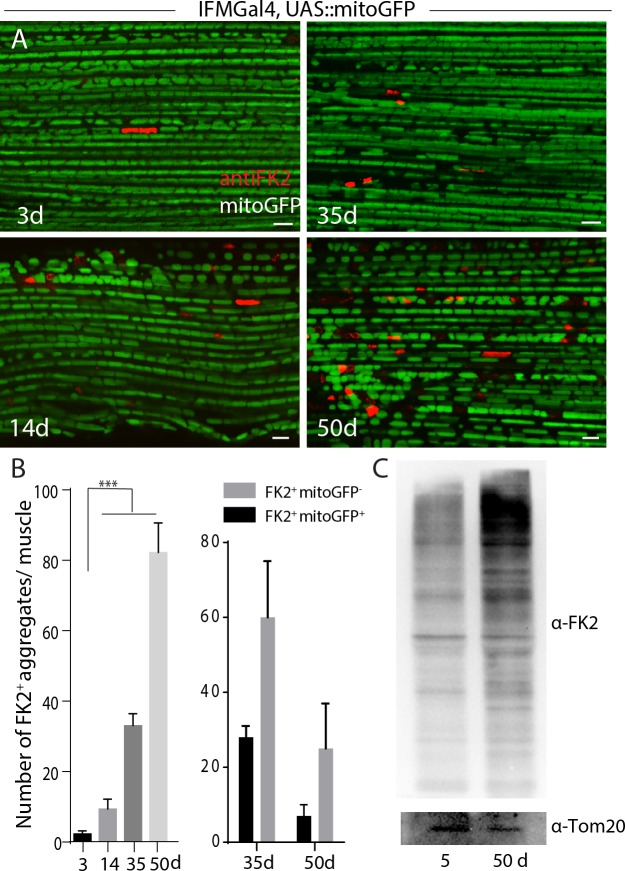
Ubiquitylated mitochondria are progressively accumulated during aging in Drosophila indirect flight muscles.A, FK2-positive ubiquitin conjugates in Drosophila IFMs were examined at different stages. B, Left, quantification of A, around 30 muscles from 5~6 animals of each time point was quantified. One-way ANOVA performed for statistics, and p<0.001 for S.E.M. Right, colocalization of mitoGFP with FK2 positive foci was quantified in muscles from 35d or 50d-old animals. Scale bar: 5 μm. C, Western-blot staining against FK2 in mitochondrial sub-fractionation of thoraces from different ages. Genotype: IFMGal4;UAS-Ref(2)PGFP.